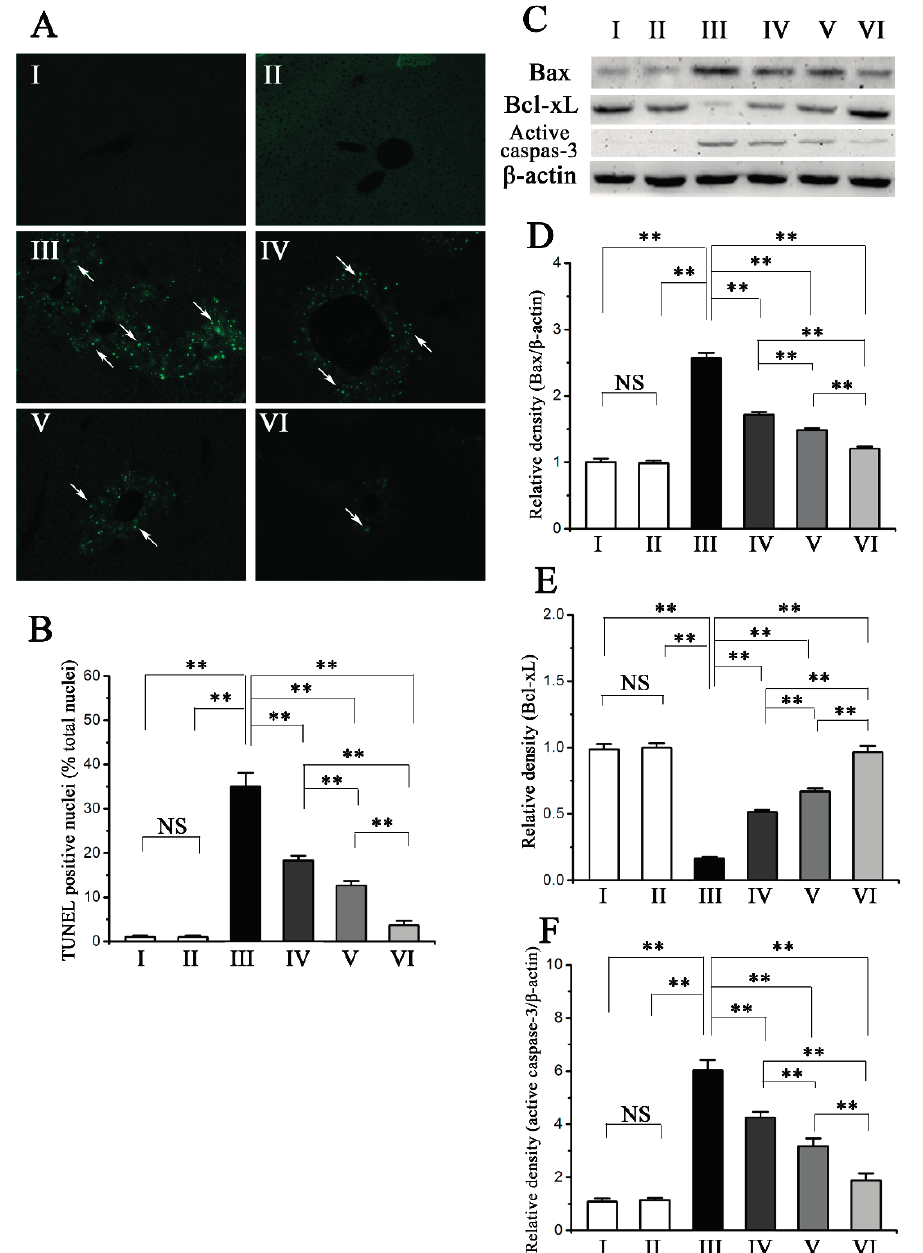
Figure 5. Pretreatment effects of procyanidin B2 on CCl 4 -induced apotosis. ( A ) TUNEL stained liver sections (magnification, 100×), green fluorescence indicated the positive cells (arrows); ( B ) Statistic analysis of the relative proportion of TUNEL positive cells in the liver of mice; ( C ) Western blot analysis of Bax, Bcl-xL and active caspase-3 proteins in response to CCl 4 and procyanidin B2; ( D ) Relative density analysis of Bax protein bands; ( E ) Relative density analysis of Bcl-xL protein bands; ( F ) Relative density analysis of active caspase-3 protein bands. Values expressed as mean ± SE in each group. NS: no significant, ** p < 0.01. n = 7. Animals were divided into following groups: I, normal control; II, procyanidin B2 control; III, model; IV, procyanidin B2 (25 mg·kg − 1 ) + CCl 4 ; V, procyanidin B2 (50 mg·kg − 1 ) + CCl 4 ; and VI, procyanidin B2 (100 mg·kg − 1 ) + CCl 4